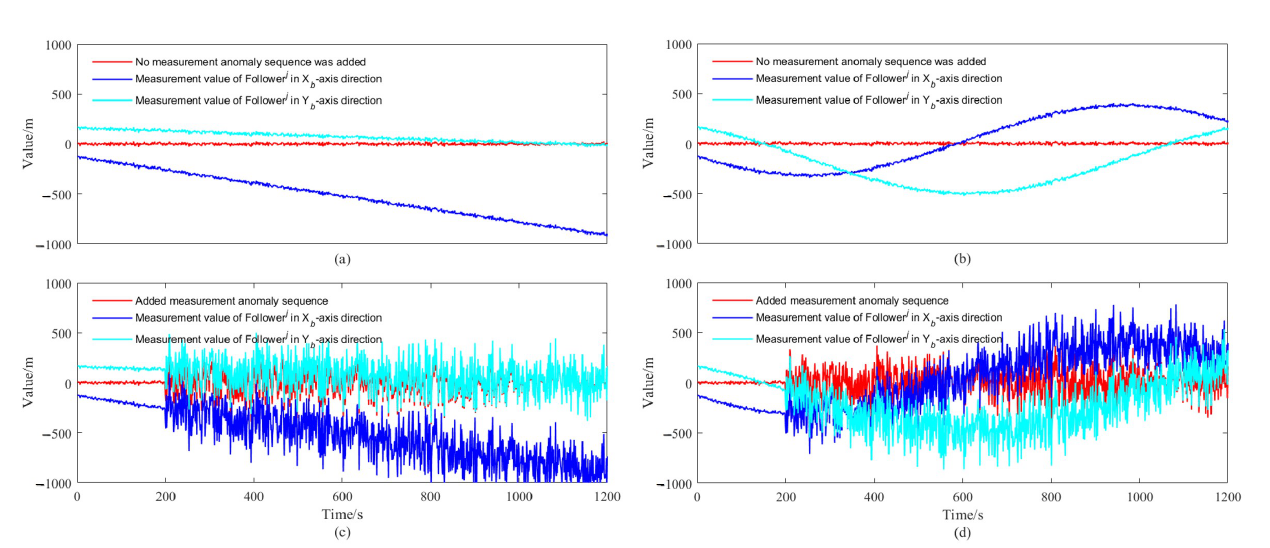
Figure 5. Measurement anomaly sequence and the components of the measurement model. ( a , c ) De- scription of the results of AUVs that moved along a straight line at a uniform constant speed; ( b , d ) description of the results of AUVs that moved along a curve at a uniform constant speed.